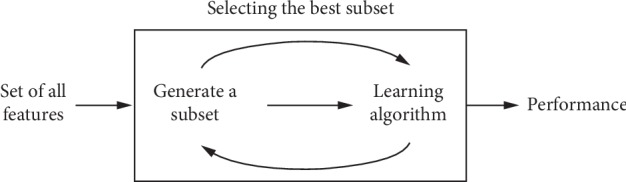
Wrapper methods.